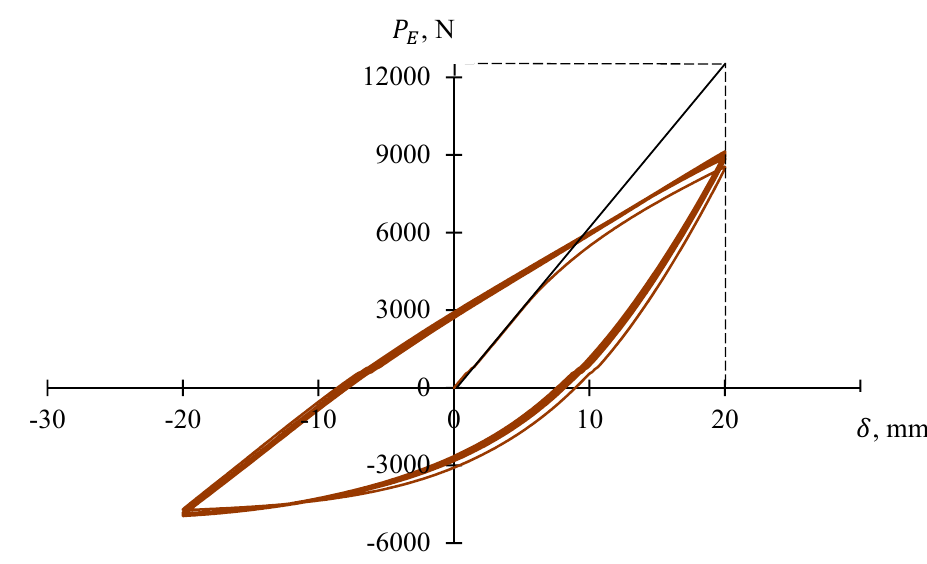
Figure 5. Typical load-displacement diagram.